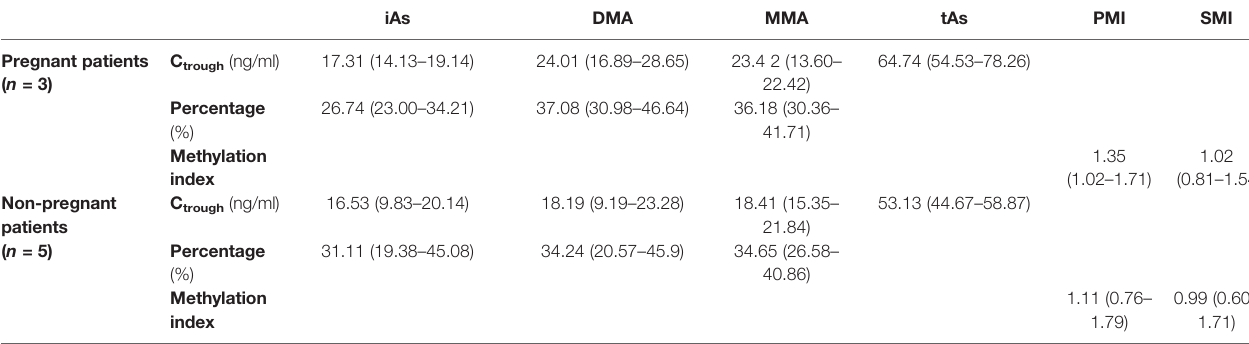
TABLE 2 | The C trough , percentage, and methylation index of arsenic species in plasma from pregnant and non-pregnant women treated with arsenic trioxide (ATO), mean (range).